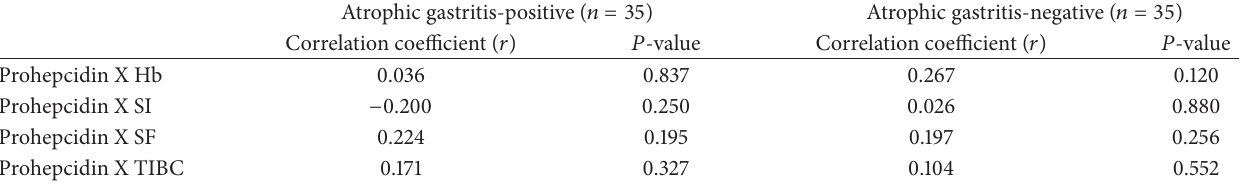
Table 2: Correlation between the serum prohepcidin and the parameters for anemia in patients with and without atrophic gastritis. Atrophic gastritis-positive ( 𝑛 = 35 ) Atrophic gastritis-negative ( 𝑛 = 35 ) Correlation coefficient ( 𝑟 )